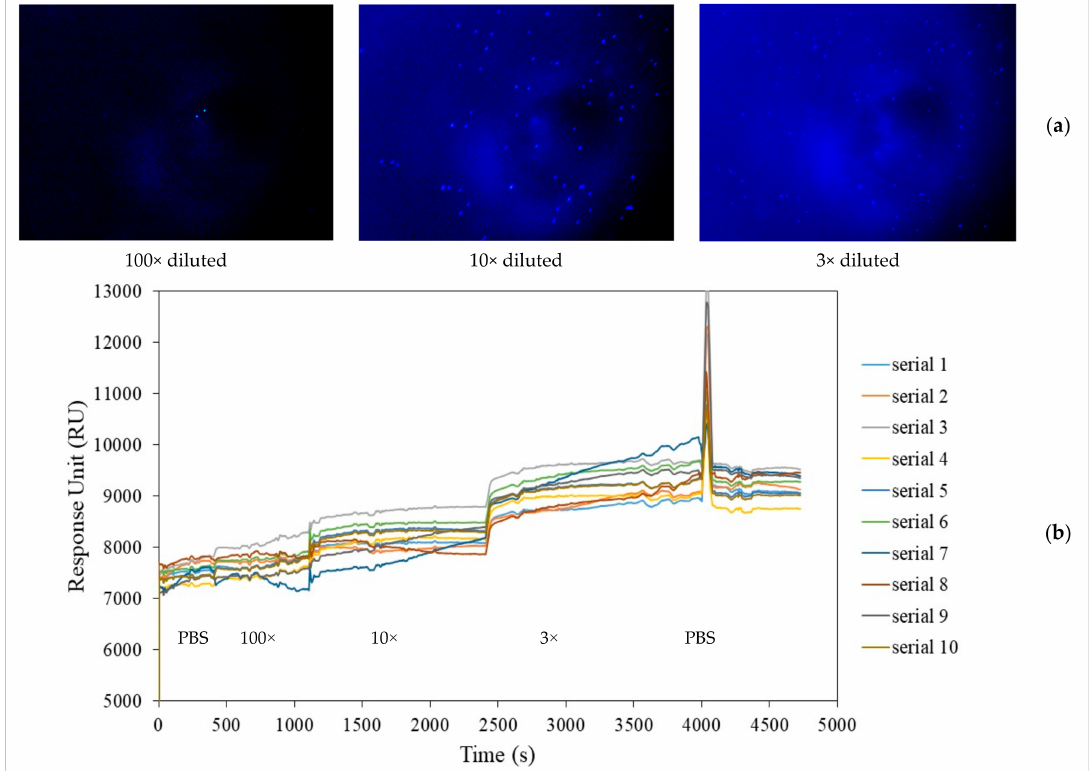
Figure 7. ( a ) Fluorescence images of A549 cell solutions with di ff erent concentrations (100 × , 10 × , and 3 × diluted A549 cell solution) on an SPR chip; ( b ) curves of SPR real-time monitoring in ten di ff erent